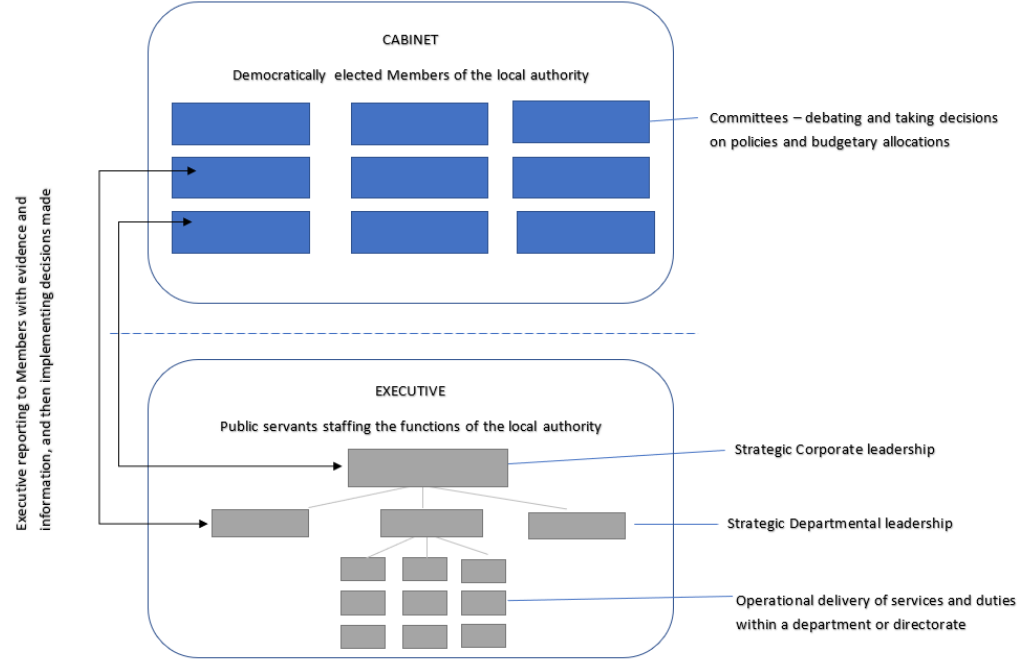
Figure 1. Stylized local authority organizational structure relevant to risk management decision- making.